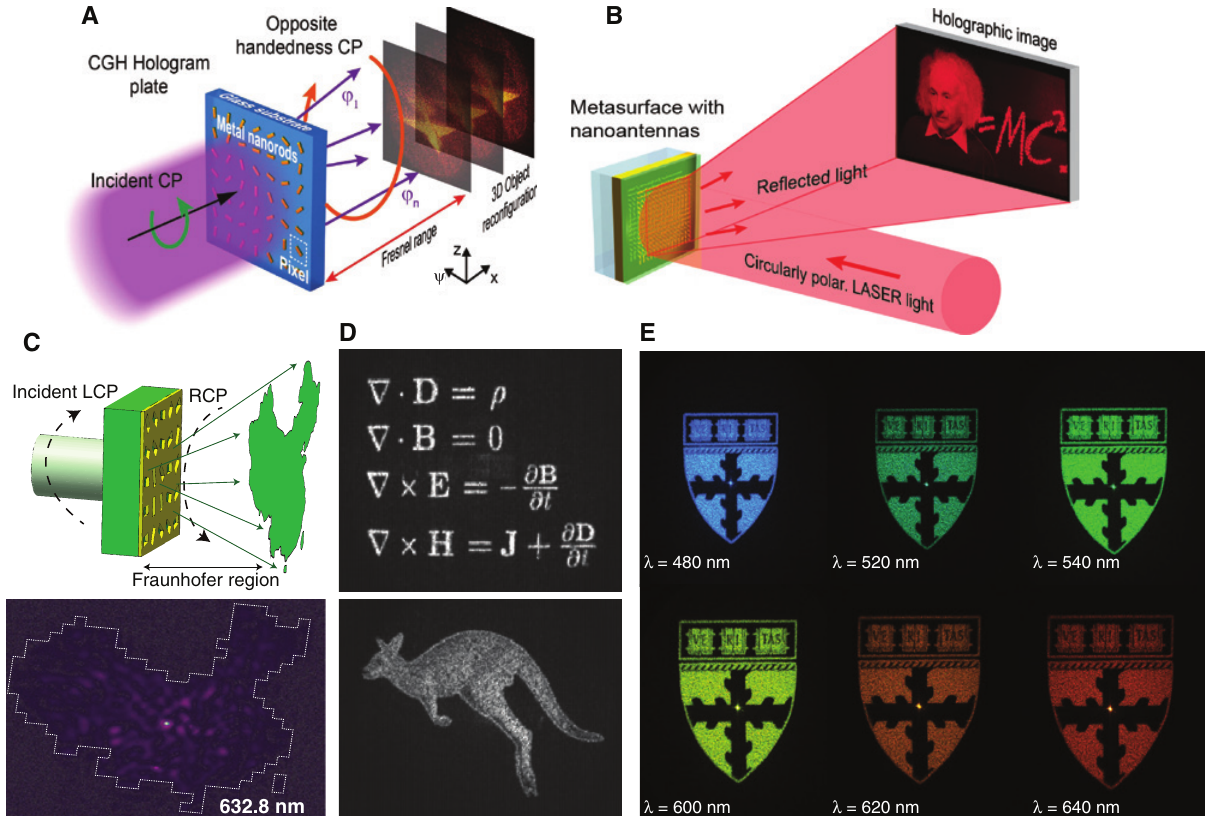
Figure 2: Phase-only metasurface holography. (A) 3D on-axis transmission-type metasurface hologram composed of gold nanorod arrays [57]; (B) 2D off-axis reflection-type metasurface hologram utilizing a metal-insulator-metal layer system for high efficiency [27]; (C) metasurface composed of nano-aperture arrays based on Babinet’s principle [62]; (D) dxperimentally obtained images using Huygens’ metasurface holograms composed of nanodisks [28]; (E) Reconstructed optical images at different wavelengths covering the entire visible spectrum by using the dielectric metasurface holograms composed of the Si nanofins [63]. Reprint permission obtained from [27, 28, 57, 62,